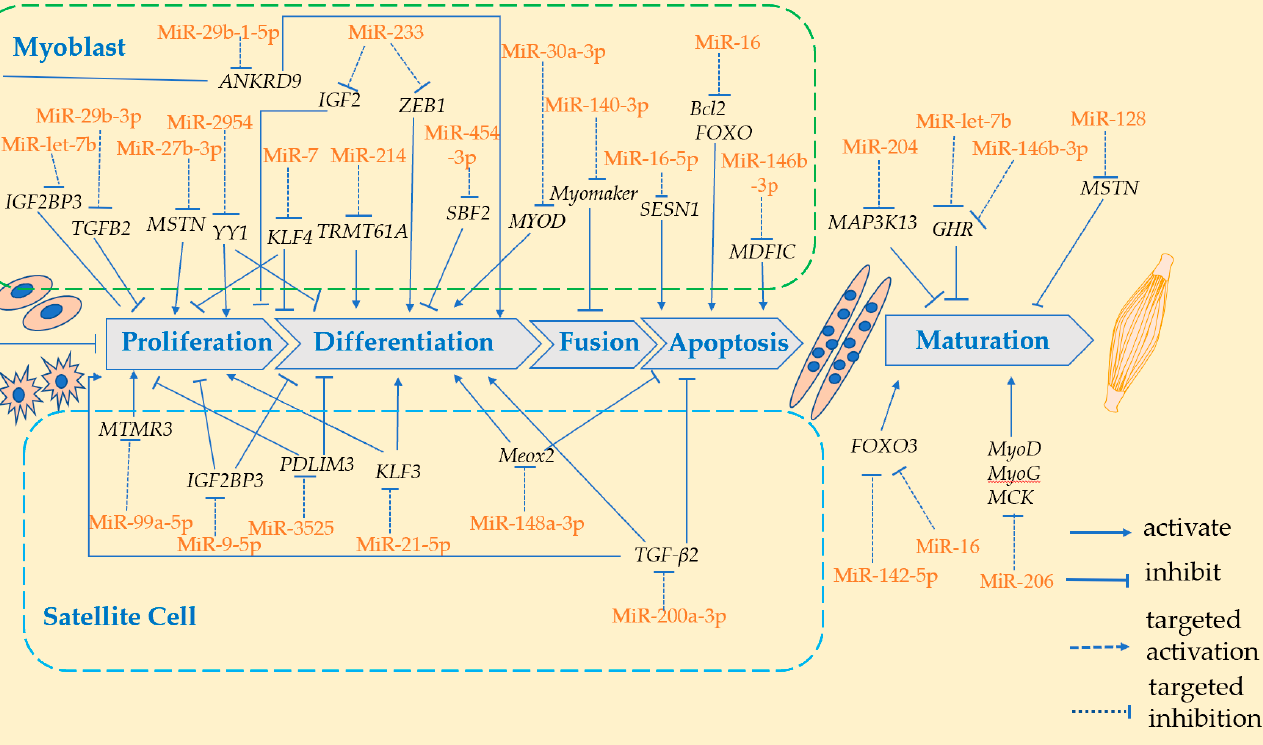
Figure 1. The role of miRNA in the growth and development of skeletal muscle in domestic chicken. MiRNA, shown in orange in the schematics, promotes or inhibits the developmental process of skeletal muscle by targeting mRNAs (shown in black italics) to cause their translation to be blocked or degraded. The majority of those miRNAs were involved in the regulation of myoblast proliferation, differentiation, fusion, and apoptosis, as well as satellite cell proliferation, differentiation, and apoptosis. Otherwise, minority miRNAs regulate muscle fiber maturation—the hypertrophy and mass changes of muscles—by targeting hormone-related genes and myogenic factors in skeletal muscle.